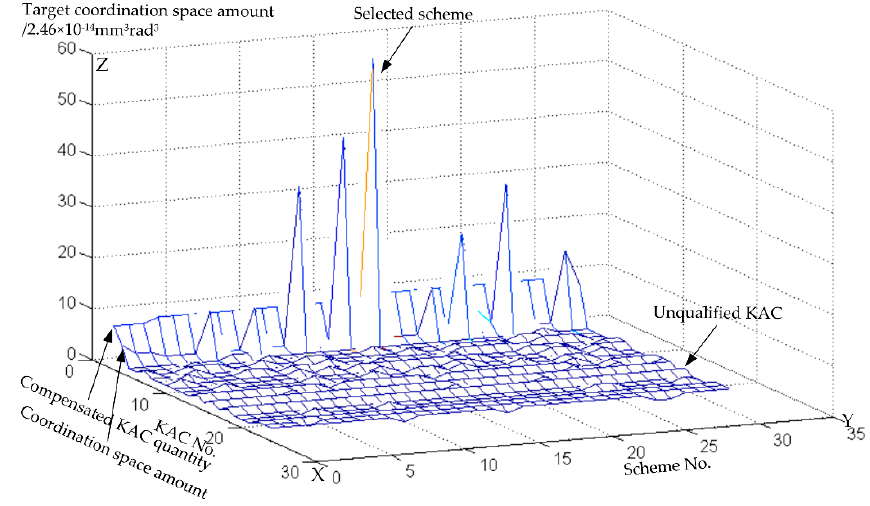
Figure 13. The accuracy compensation schemes.